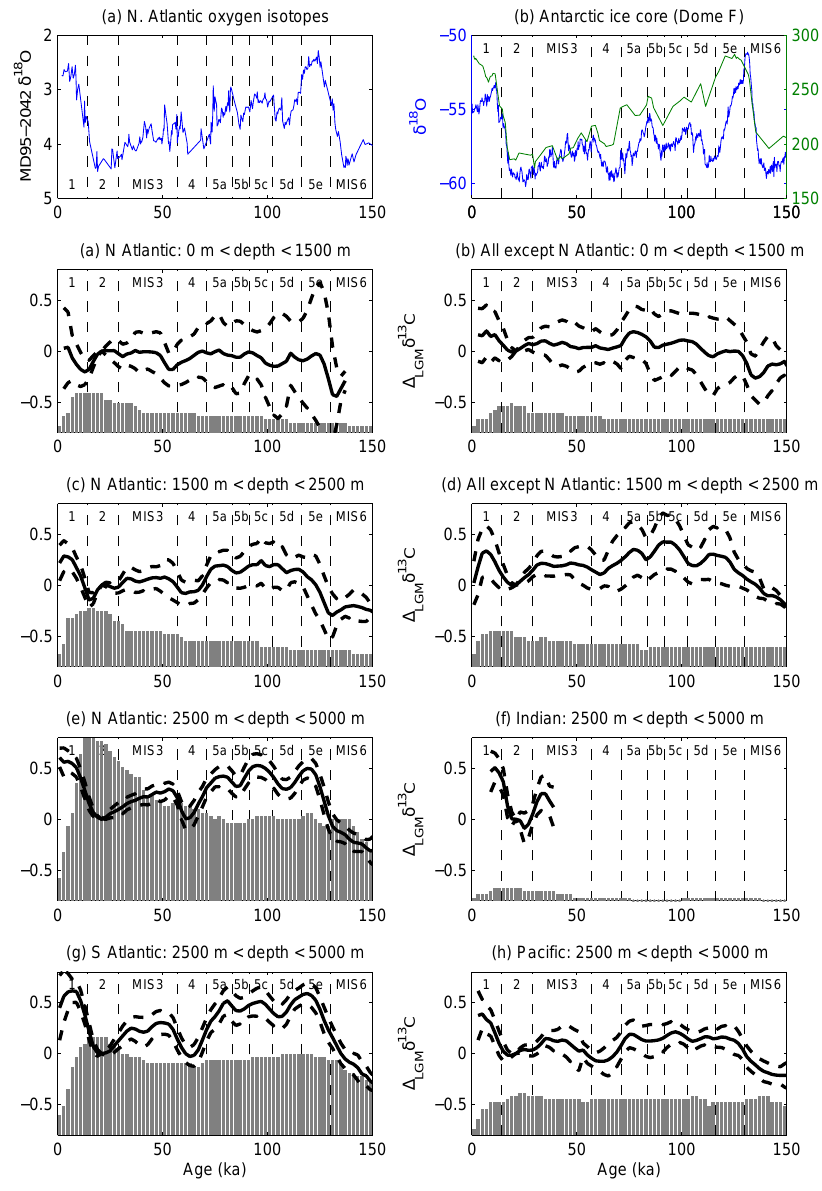
Fig. 7. Mean and 2 × standard error, weighted by the square of the inverse of the error estimate, of benthic 1 LGM δ 13 C in each region. The histogram indicates the number of records used; where this is fewer than three, no data are plotted. Panel (a) shows δ 18 O from core MD95-2042 in the North Atlantic (37.8 ◦ N; 10.2 ◦ E; 3146m). Panel (b) shows CO 2 and δ 18 O from the Dome Fuji ice core (Kawamura et al., 2007); note that the age model used in this study is based on the Kawamura et al. (2007)